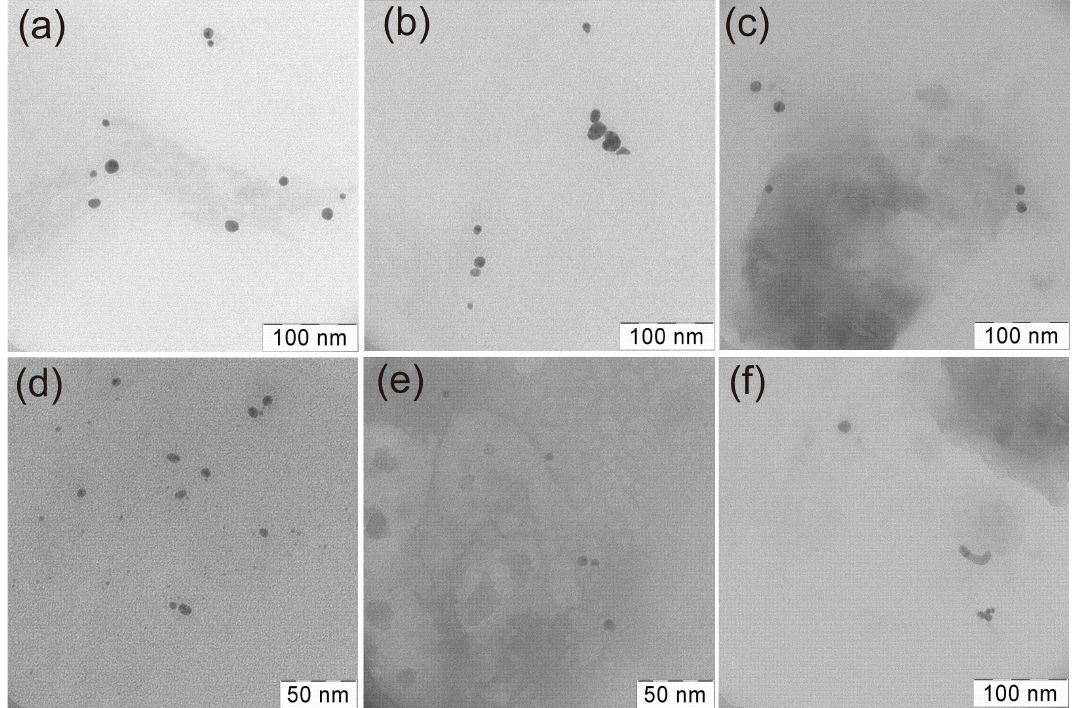
Figure 4 . TEM micrographs of samples: VM/Au 0 /ZnO ( a ), EM/Au 0 /ZnO ( b ), SM/Au 0 /ZnO ( c ), VM/Ag 0 /ZnO ( d ), EM/Ag 0 /ZnO ( e ), SM/Ag 0 /ZnO ( f ).